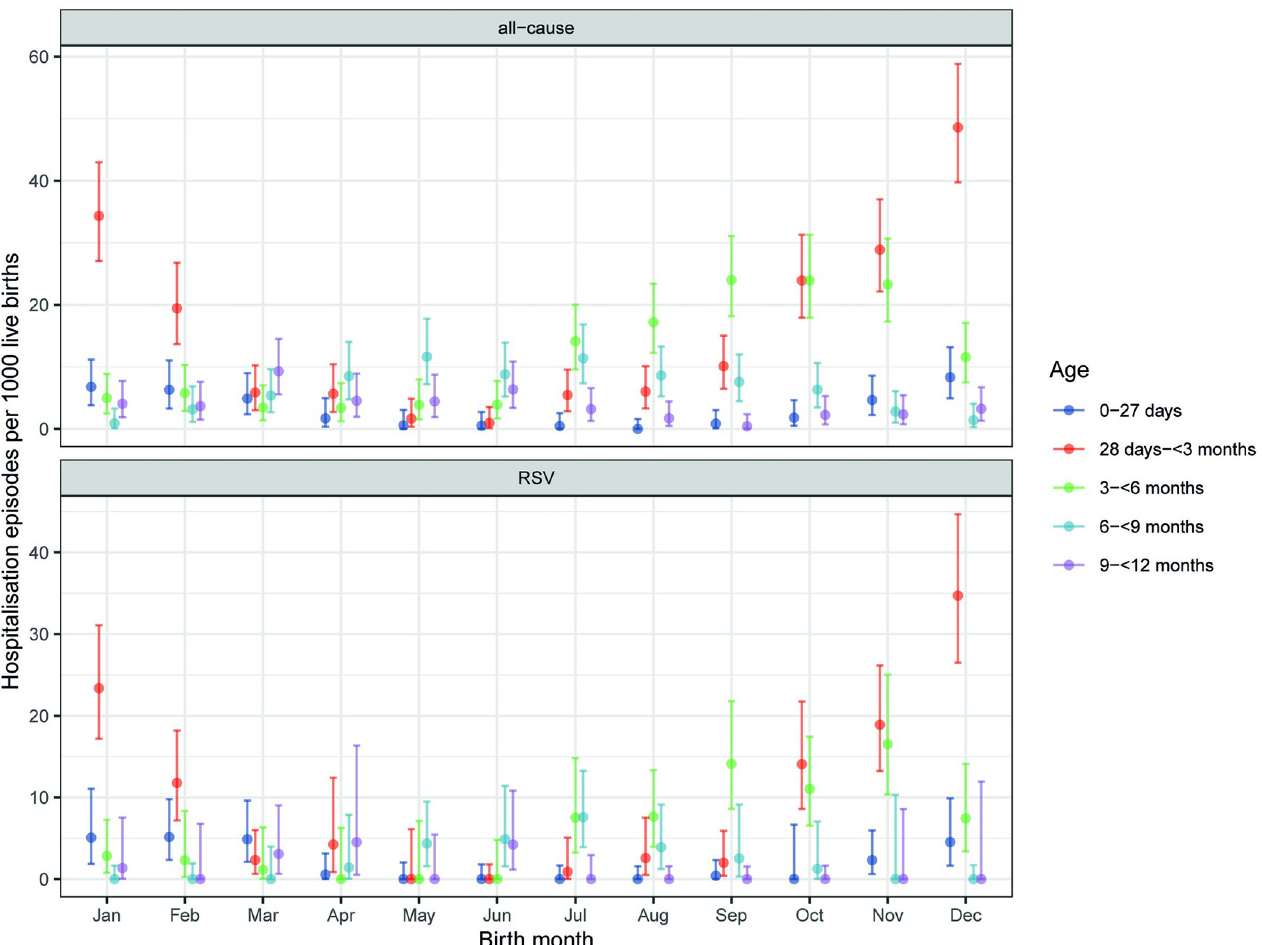
Fig 3. Annual hospitalisation rates of all-cause and RSV-associated ALRI in the first year of life (per 1000 live births) by birth month. RSV = respiratory syncytial virus; ALRI = acute lower respiratory infection.